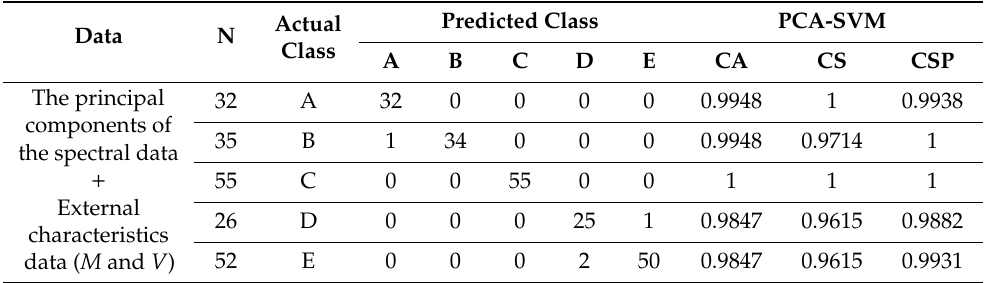
Table 6. The influence of multi-source data fusion on the predictive performance of PCA-SVM.